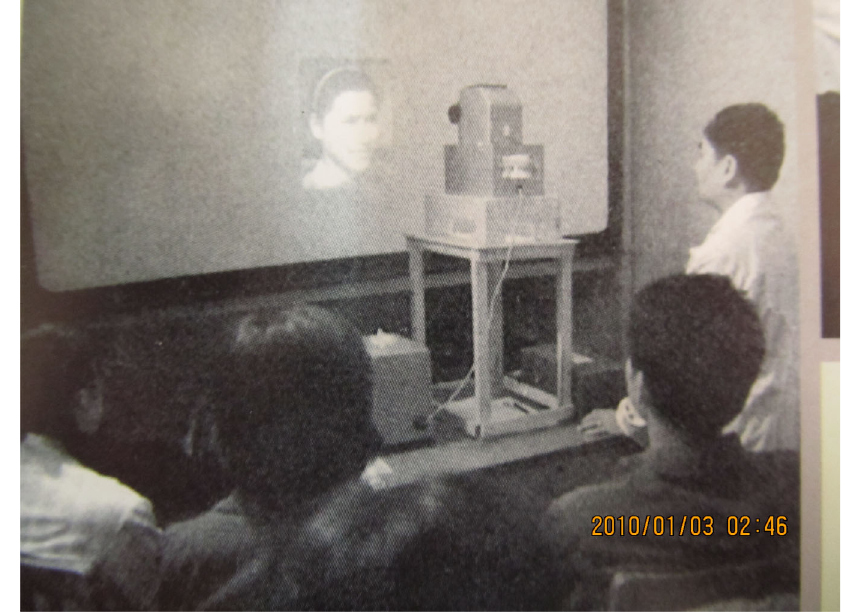
Figure 2. Skin color measurement (Fu,